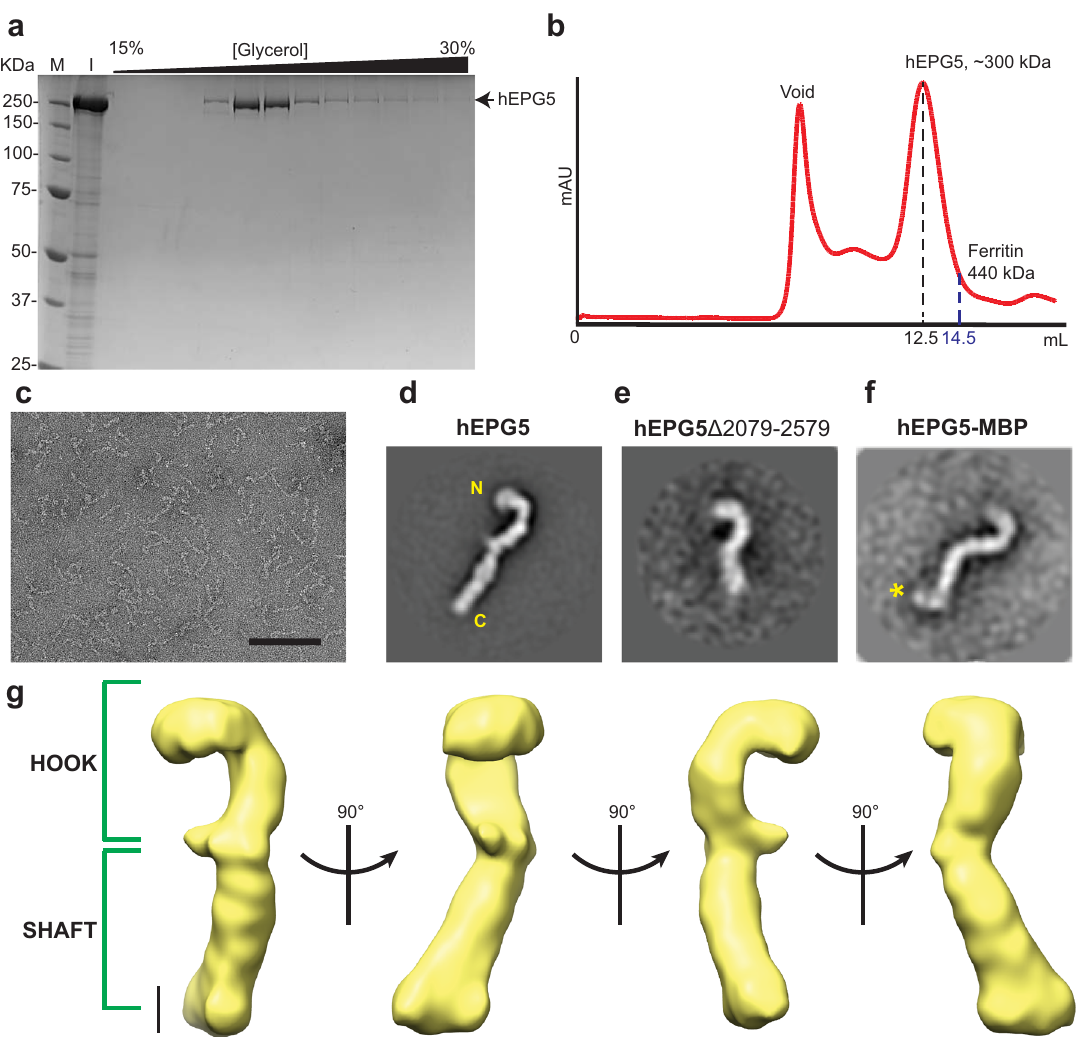
Fig. 1 Overall architecture of hEPG5. a SDS – PAGE of His-FLAG-hEPG5 glycerol gradient ultracentrifugation fractions, stained with Coomassie Blue. M and I represent the protein marker and input, respectively. b Analytical gel fi ltration chromatography of His-FLAG-hEPG5. Elution volume of hEPG5 (~300 kDa including the tags) is indicated by black dashed line and the molecular weight standard ferritin (440 kDa) is indicated by blue dashed line. c A representative raw image of negatively stained hEPG5 (Scale bar: 100 nm). d Representative 2D class averages of wild-type hEPG5, with the location of N- and C- termini indicated in yellow. e Representative 2D class averages of hEPG5 Δ 2079 – 2579 . f Representative 2D class averages of C-terminal maltose- binding protein (MBP)-tagged hEPG5. MBP density is shown by asterisk (yellow). g 3D reconstruction of hEPG5 revealing the hook and shaft regions (Scale bar: 5